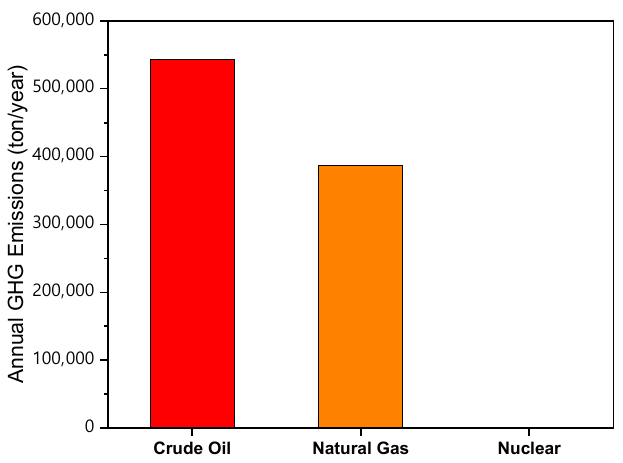
Figure 10. Estimated GHG emissions of different energy sources to operate the existing MED-TVC desalination plant.